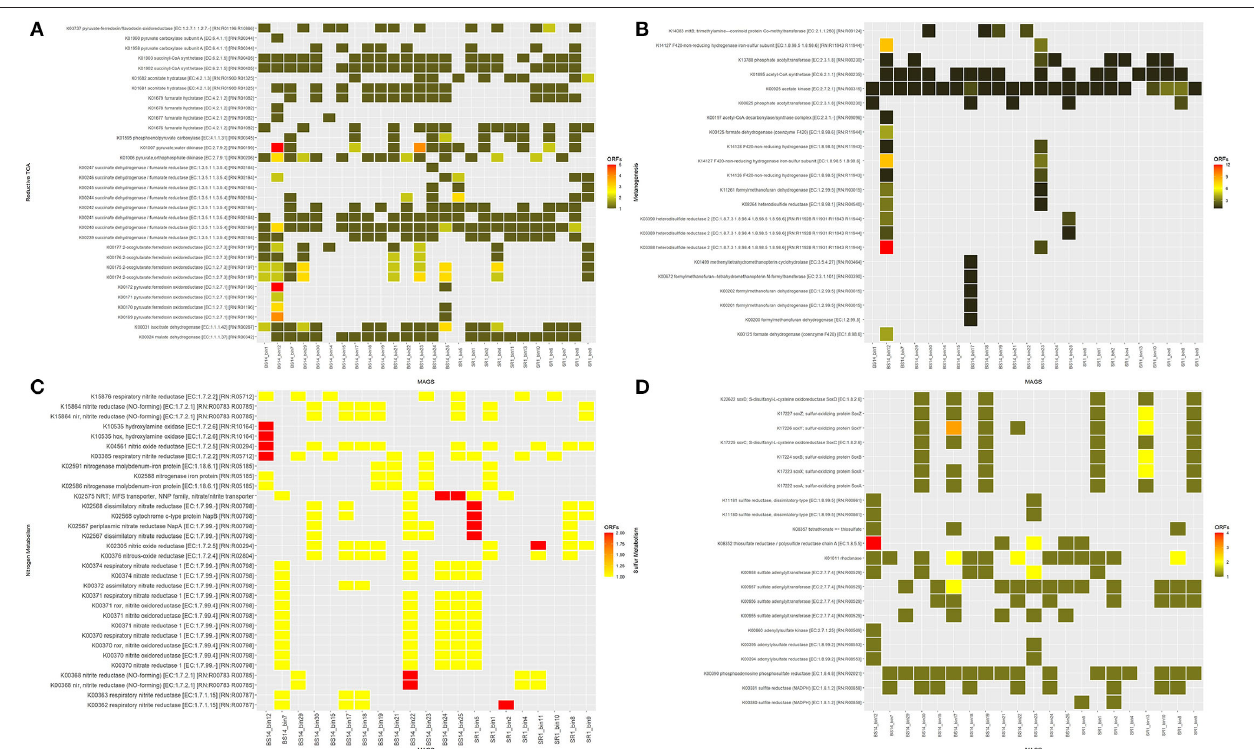
FIGURE 12 | Functional annotation of metagenome-assembled genomes (MAGs) (BS14 and SR1) for the presence of crucial enzymes involved in (A) reductive TCA; (B) nitrogen metabolism; (C) sulfur metabolism; and (D)